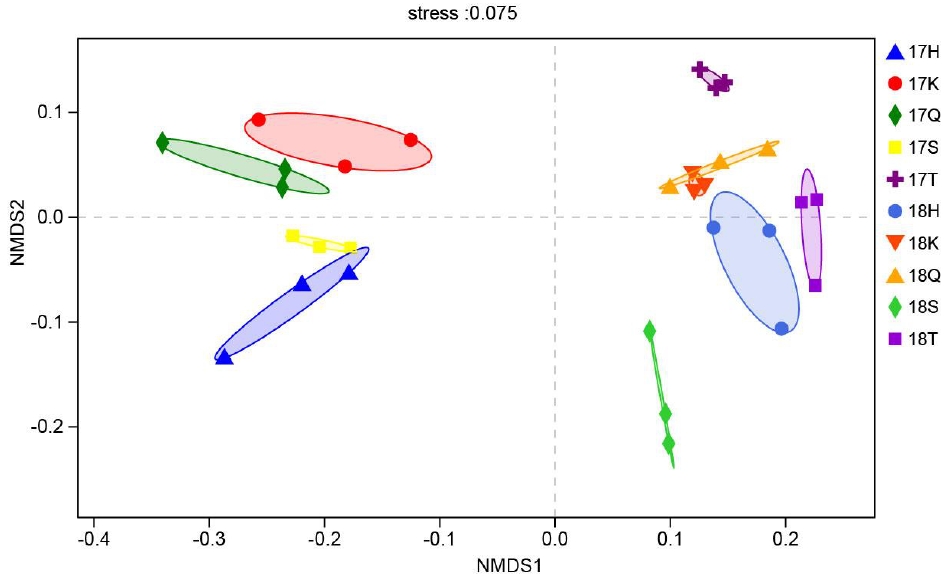
Figure 3. NMDS analysis of planktonic eukaryote community diversity.